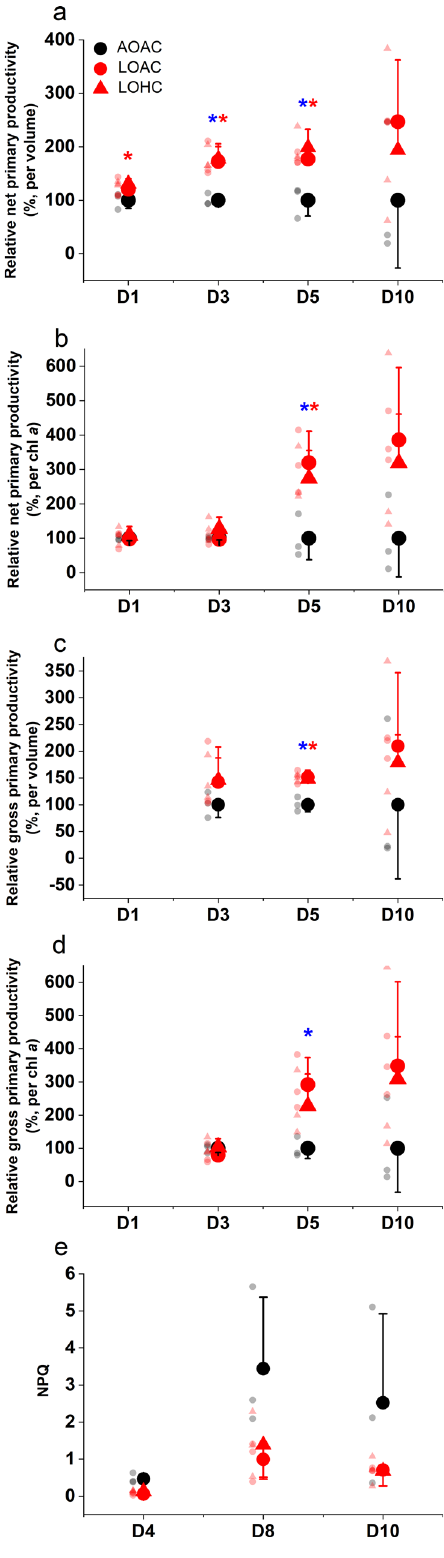
Reduced O 2 availability decreased nonphotochemical quenching (NPQ), an indicator of photosynthetic energy loss as heat dissipation and a signal of light stress (Fig. 2e), though only marginally signi fi cant changes were observed at day 4 ( P = 0.0531 for LOAC and P = 0.086 for LOHC) and day 8 ( P = 0.0552, 0.0932). In parallel, reduced O 2 level increased photochemical yield